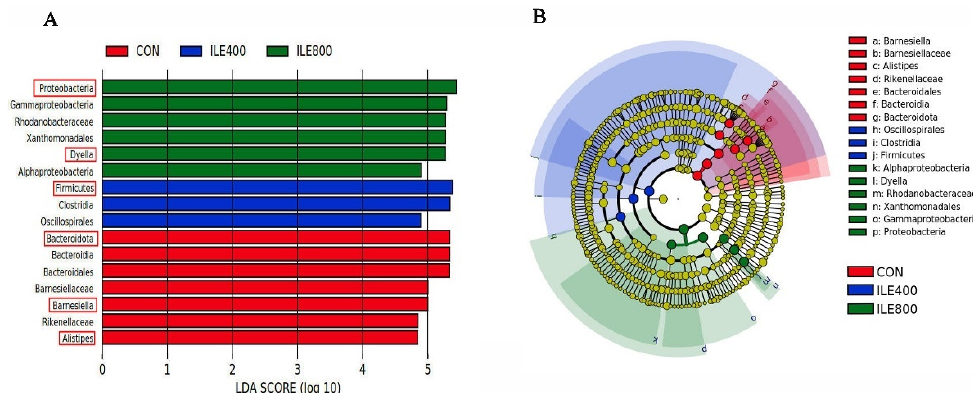
Figure 5. The linear discriminant analysis effect size (LEfSe) analysis of differential microbial taxa in